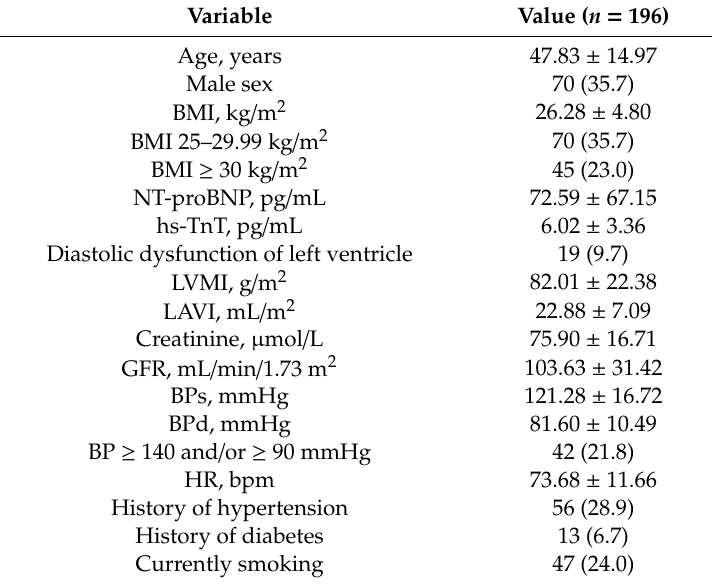
Table 1. Characteristics of the